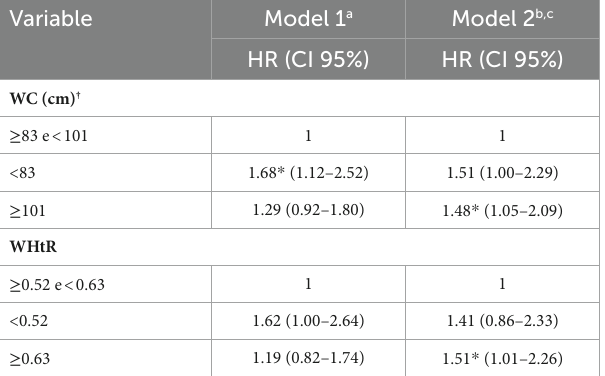
TABLE 2 Simple and multiple analyses of the association between waist circumference (WC), waist-to-height ratio (WHtR), and mortality in older adults. Viçosa, MG, Brazil, 2009–2018.